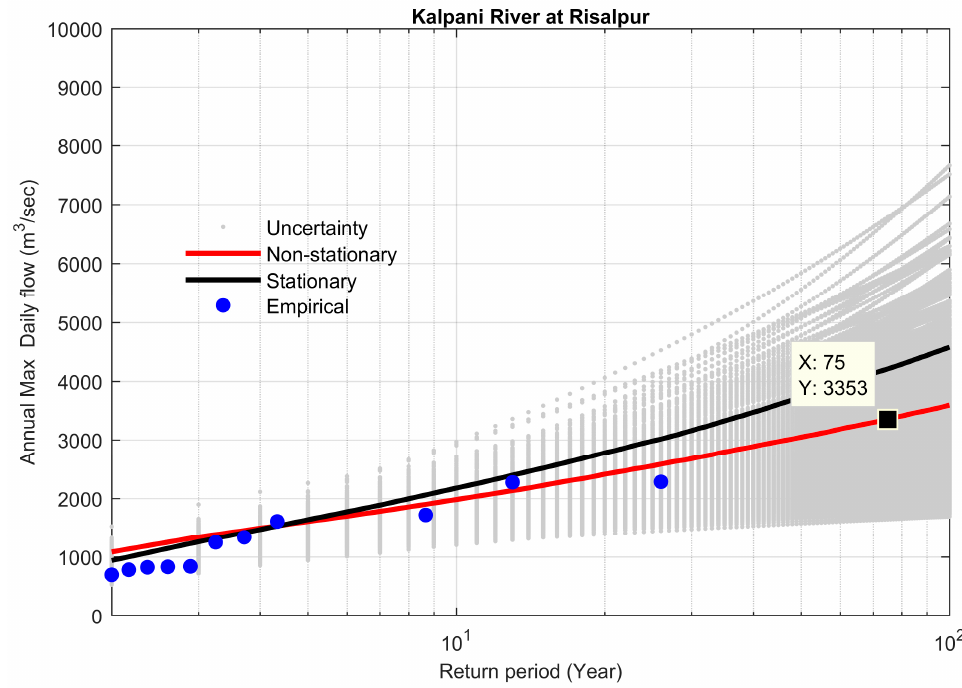
Figure 19. Comparison between non-stationary and stationary FFCs at site 19, along with non- stationary uncertainty bounds for the year 2009.